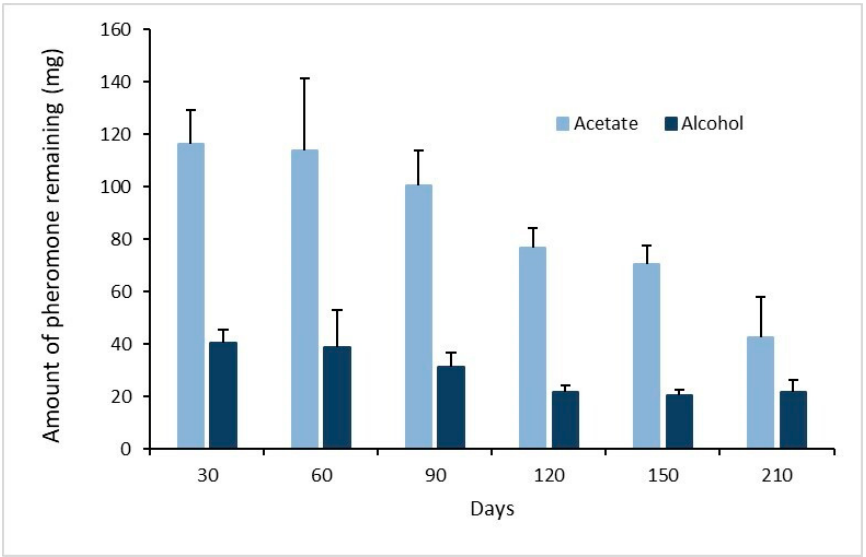
Figure 6. Average amount of pheromone remaining ( μ g ± SE) per point source (SPLAT matrix loaded as described above, n = 5) aged up to 210 days under field conditions.